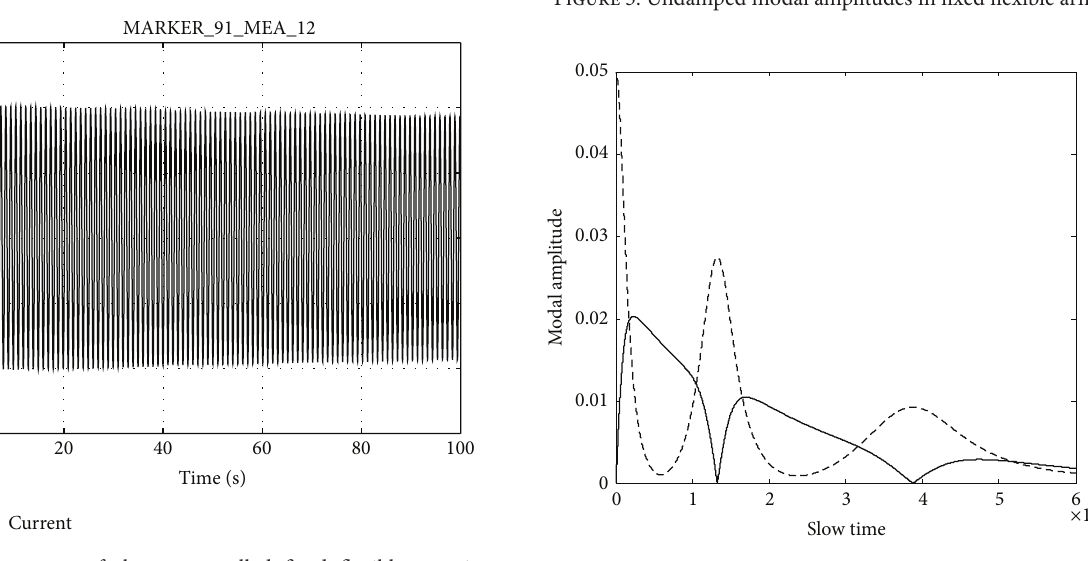
Figure 6: Damped modal amplitudes in fixed flexible